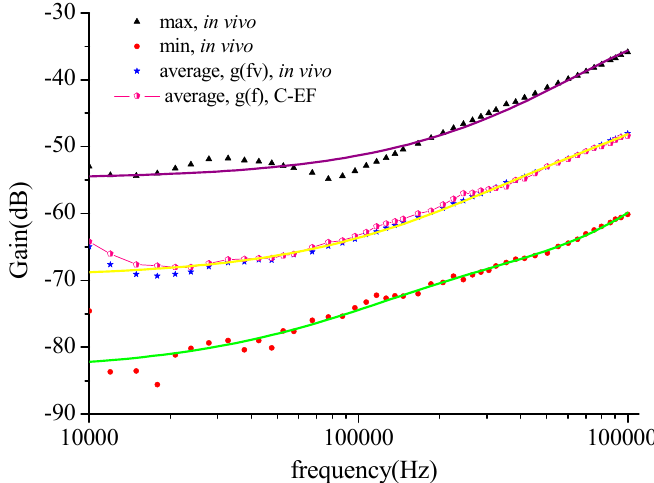
Figure 12. Mean values of the long distance human body channel amplitude characteristic variation range, measured on 10 test subjects. The star curve and red dot line curve represent the average voltage gain for the channel length in the range of 20 cm to 40 cm.